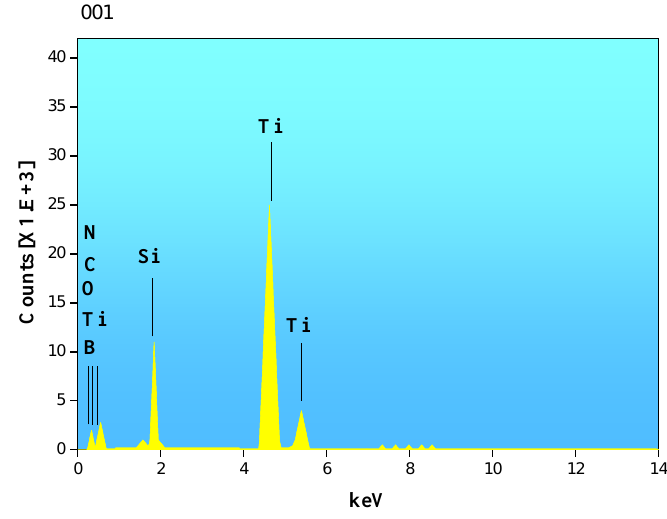
Figure 9. Relative intensity of sintered composites as measured by XRD: (a) TiB 2 -15Si 3 N 4 -3B 4 N, (b) TiB 2 -15 Si 3 N 4 -6B 4 N, (c) TiB 2 -30Si 3 N 4 -3B 4 N, and (d) TiB 2 -30 Si 3 N 4 -6B 4 N.